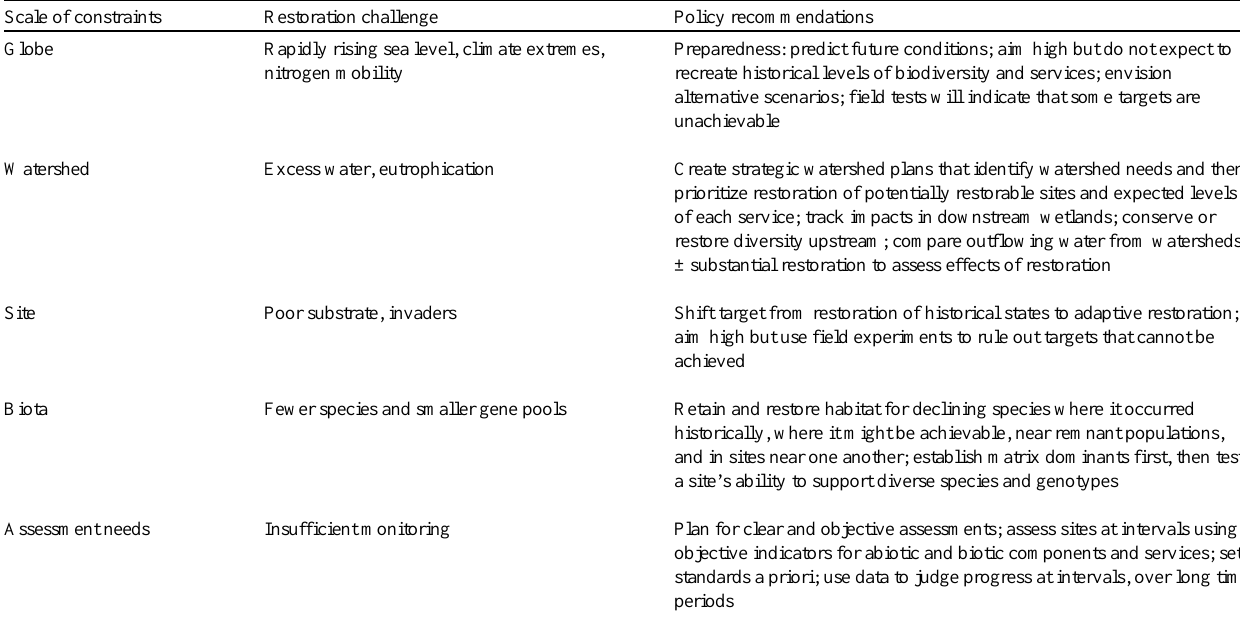
Table 1. Constraints on restoration of downstream wetlands, and recommended policies for landscape-change